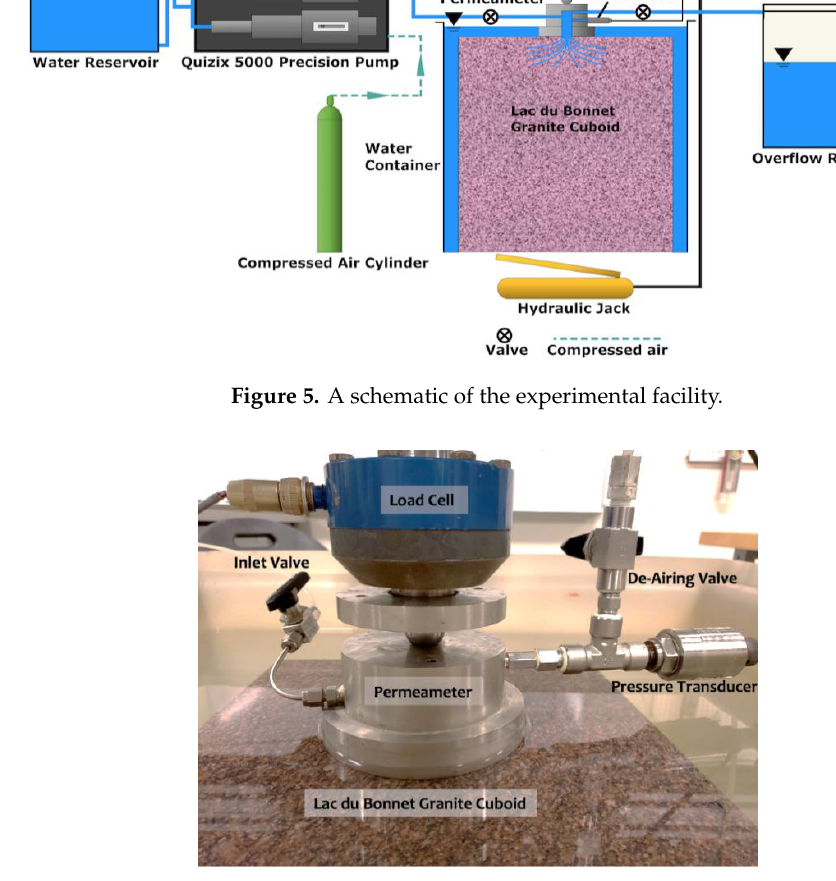
Figure 6. Detail of the permeameter.